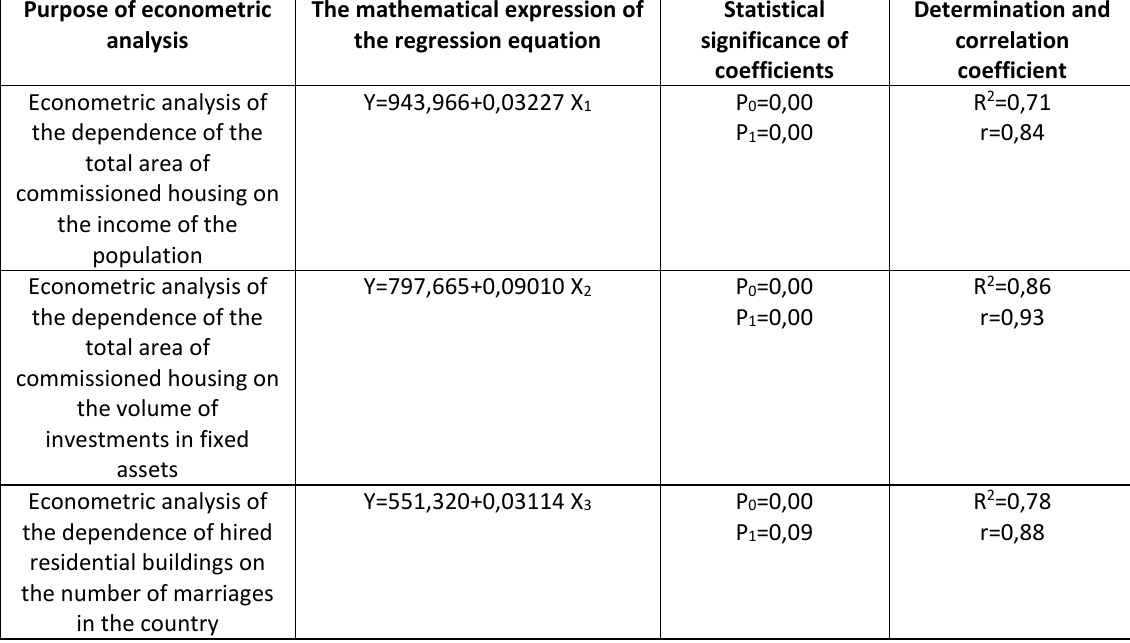
Table 2 Regression analysis according to the Eviews program Purpose of econometric The mathematical expression of analysis the regression